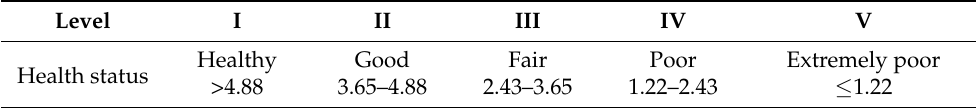
Table 2. The classification standards of eco-health status in the Wanan River